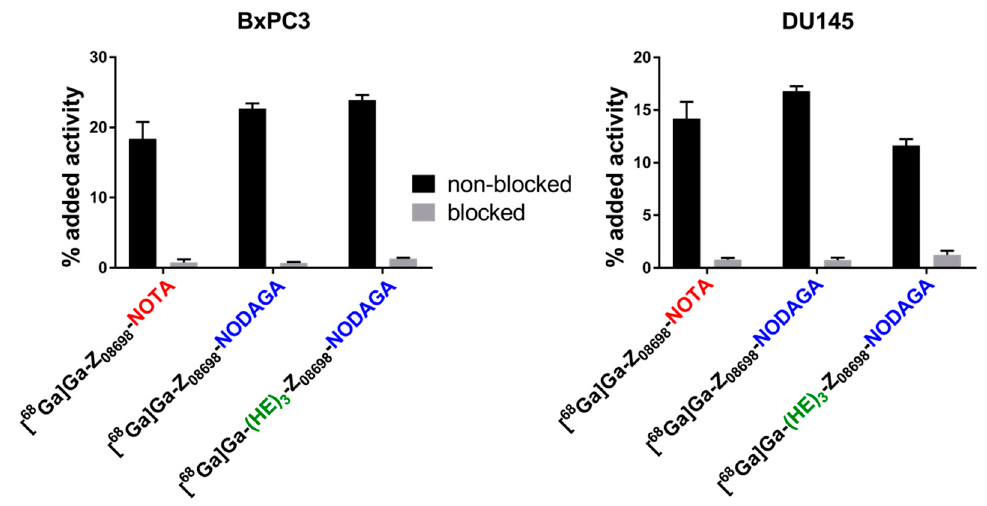
Figure 1. In vitro specificity test. HER3 receptors in the blocked group were pre-saturated by addition of 500-fold molar excess of non-labeled anti-HER3 affibody molecule.